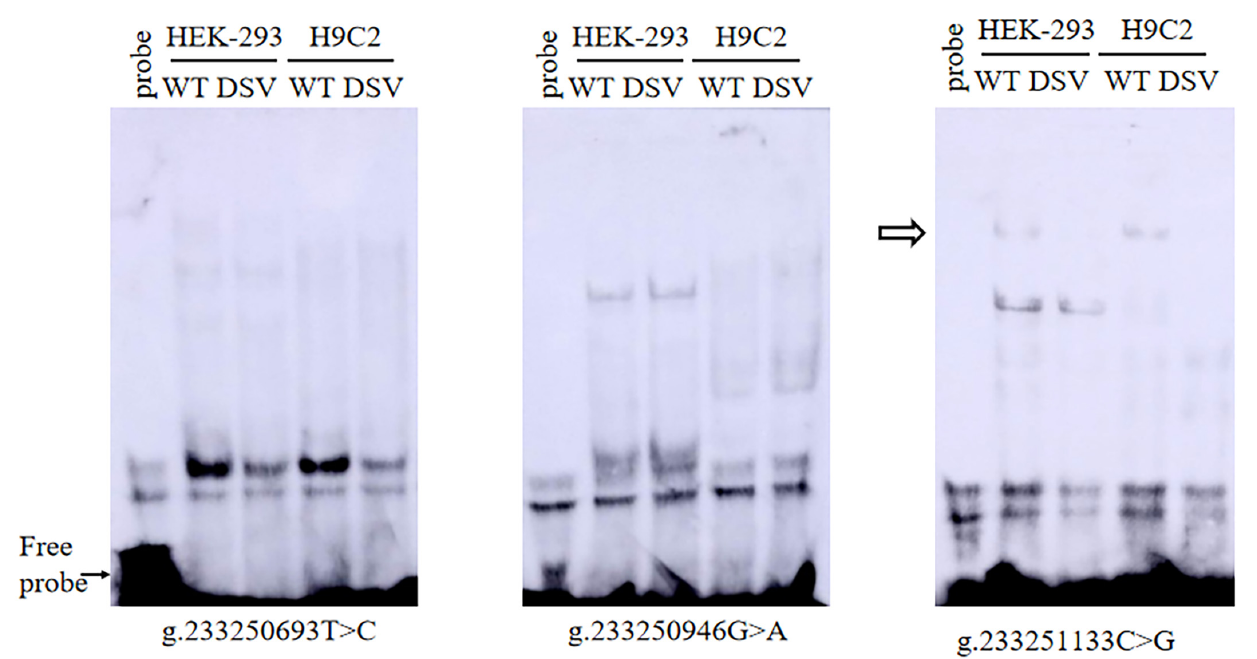
FIGURE 5 | EMSA of SNPs biotin-labeled oligonucleotides in AMI patients. Wild-type and mutant oligonucleotides (30 bp) were designed, and SNPs of AMI patients were labeled with biotin, including [g.233250693 T > C (rs185213911), g.233250946 G > A (rs568956599), and g.233251133 C > G (rs1301744254)]. EMSA was conducted with biotinylated oligonucleotides and the nuclear extracts from HEK-293 and H9c2 cells. The free probe was marked with an arrow at the bottom. The affected binding for transcription factors was marked with an open